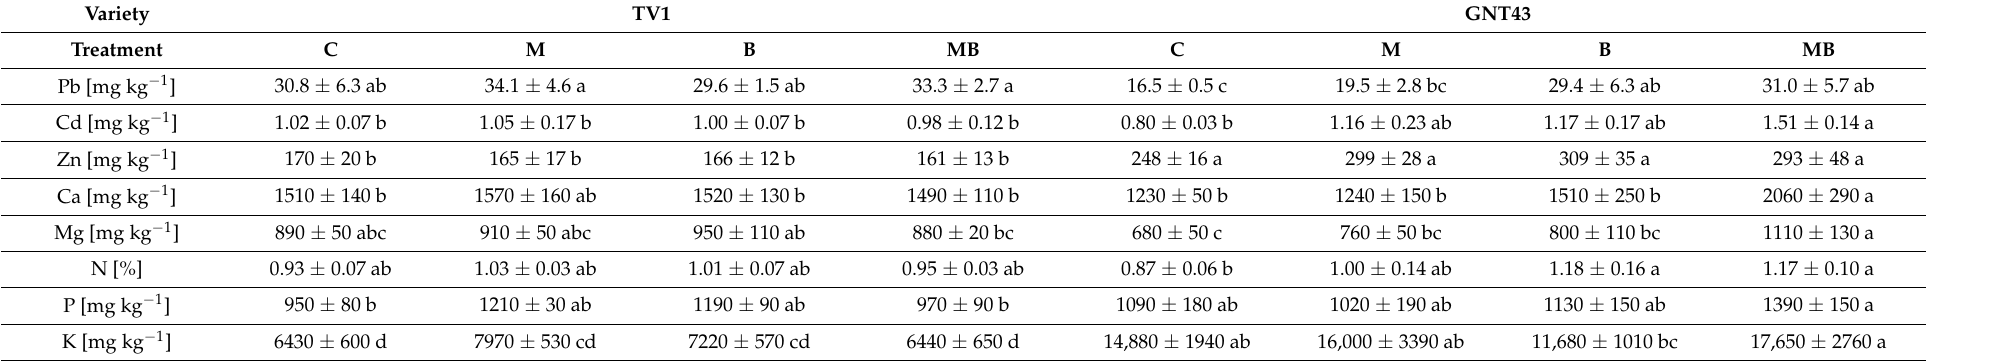
Table 2. Accumulation of selected elements in shoots of TV1 or GNT43 hybrids under different agrotechnical treatments. Variety